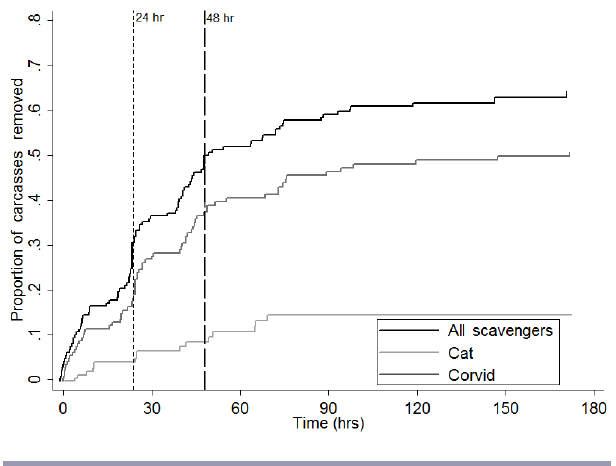
Fig. 2 . Kaplan-Meier Failure curves showing the proportional removal of 154 bird carcasses by scavengers through time (placement of the carcass = 0). The “All scavengers” curve plots the carcass removal by any scavenger, while the “Cat” and “Corvid” curves plot carcass removal by the two most common scavenger types. This experiment was documented using time- lapse cameras at 44 homes near Edmonton, Alberta,